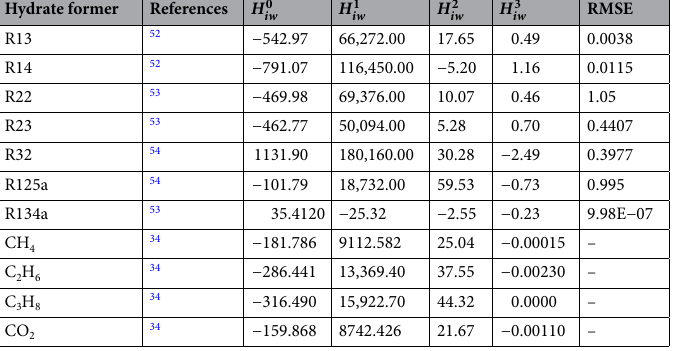
Table 3. Estimated Henry’s law constants and root mean square error (RMSE) of solubility estimates with respect to their experimental data 52–54 .